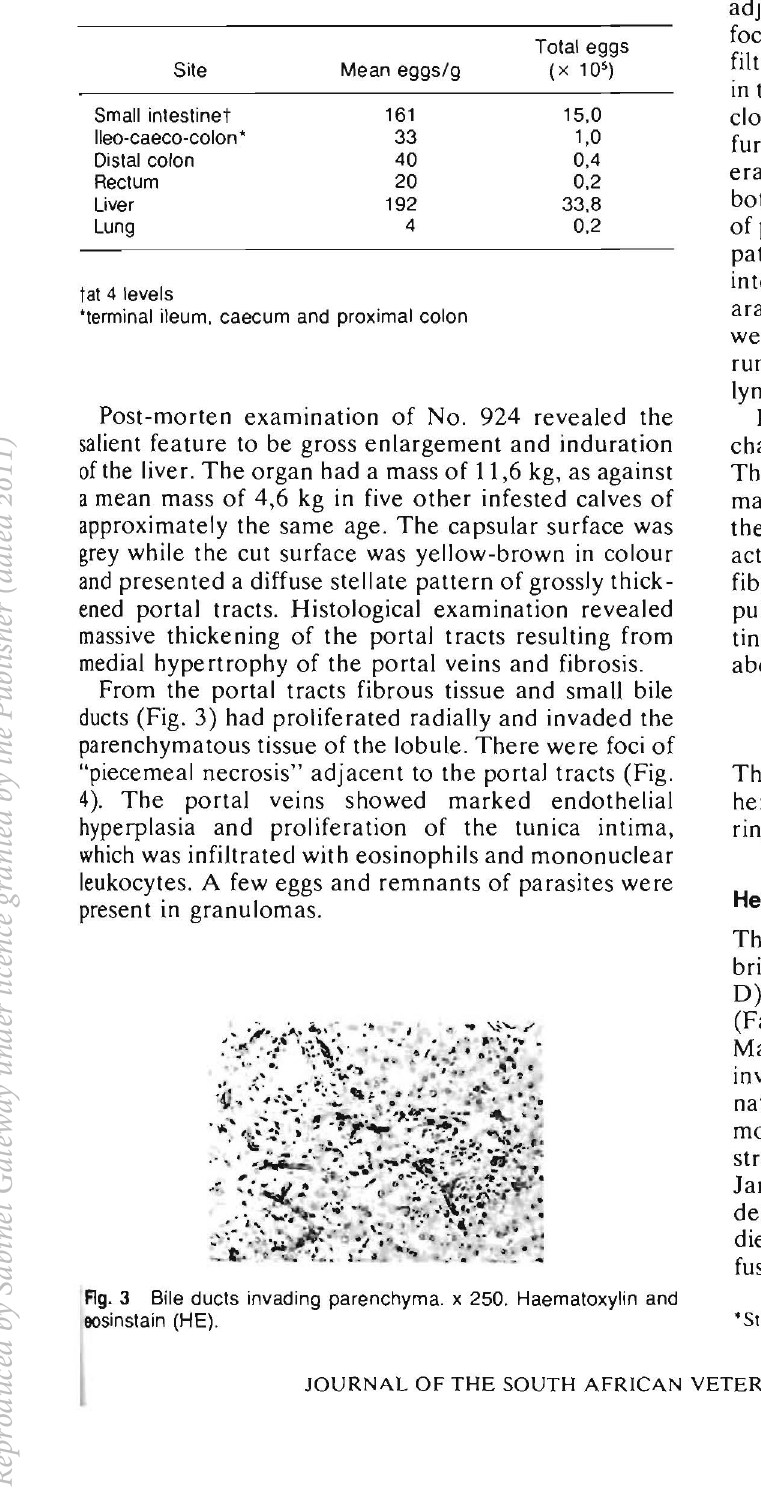
Table 1: TISSUE EGG COUNTS IN CALF NO. 924